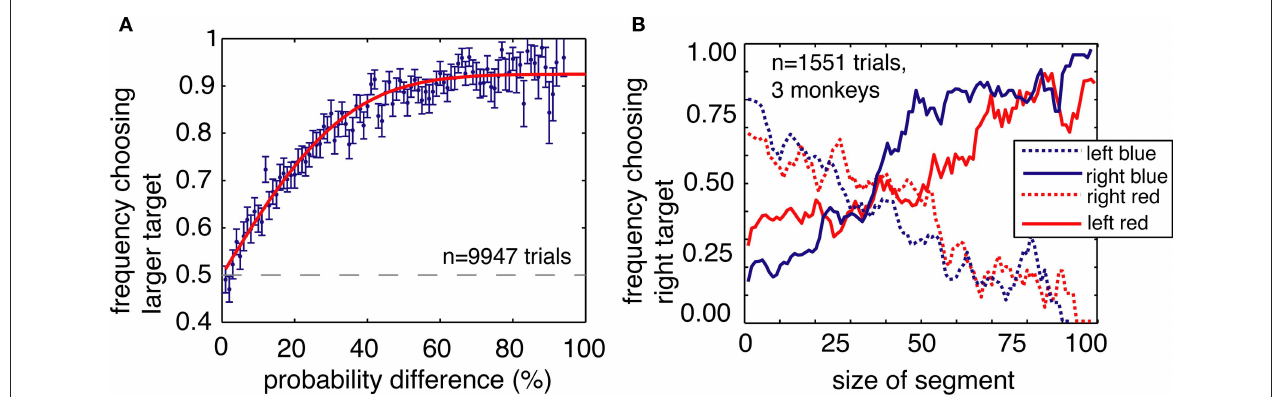
red and blue portions of the bars on the left and the right (as indicated in the legend to the right of the plot). Horizontal axis corresponds to size of either red or blue bar portion. Vertical axis indicates probability of choosing right-side target. Preferences vary roughly with both blue and red bar portions, indicating that monkeys attend to both in their decisions. Data is smoothed for